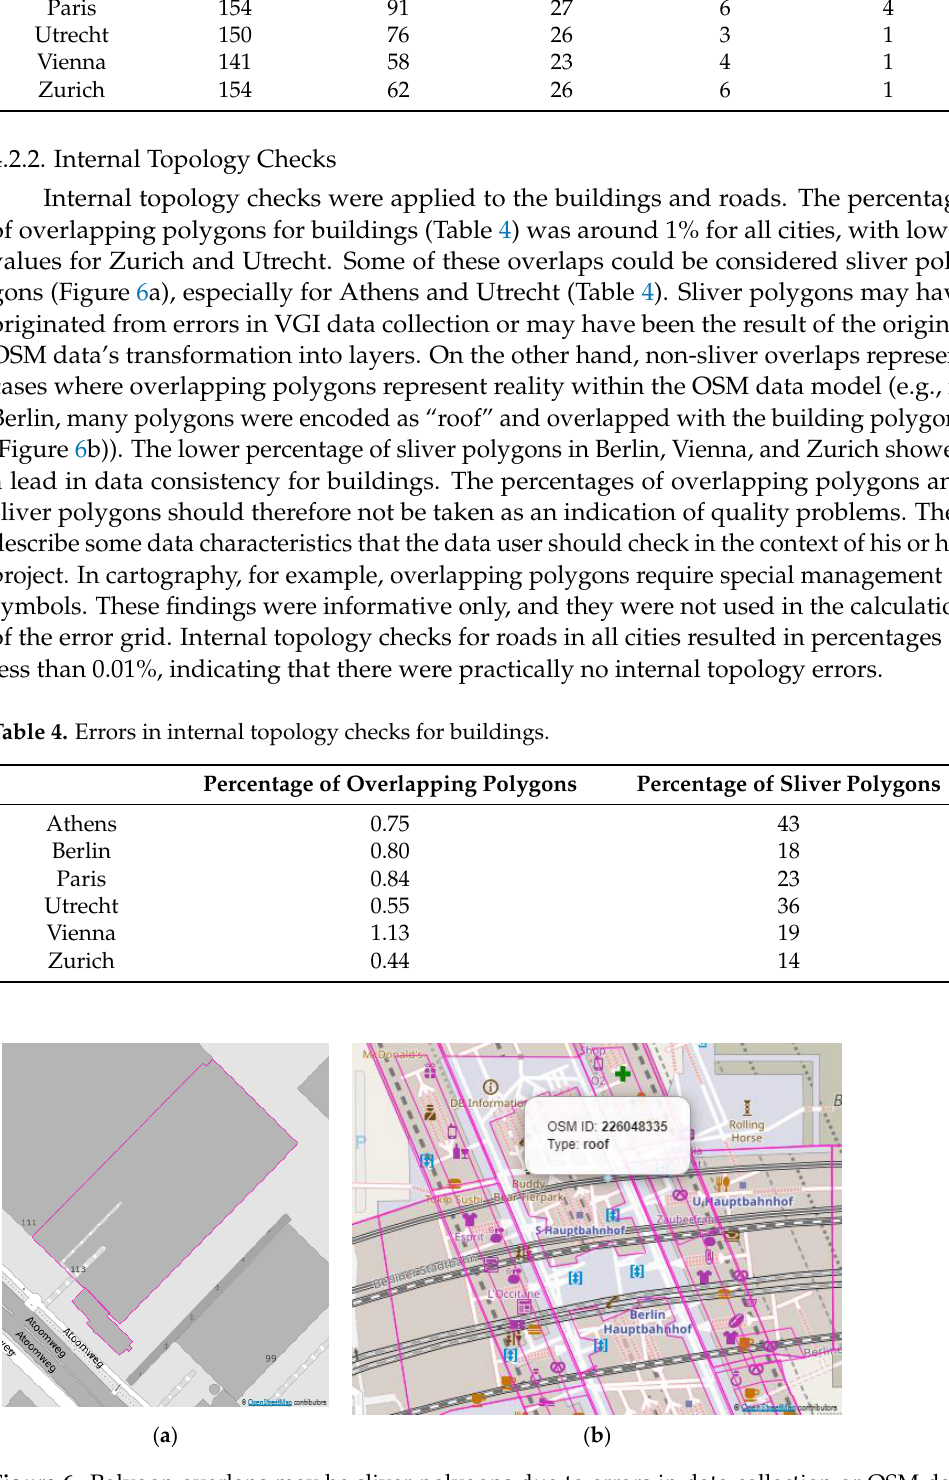
Figure 6. Polygon overlaps may be sliver polygons due to errors in data collection or OSM data transformation to layers ( a ) (Utrecht) or represent reality within the OSM data model (e.g., in Berlin, many polygons were encoded as “roof” and overlapped with the building polygons) ( b ).